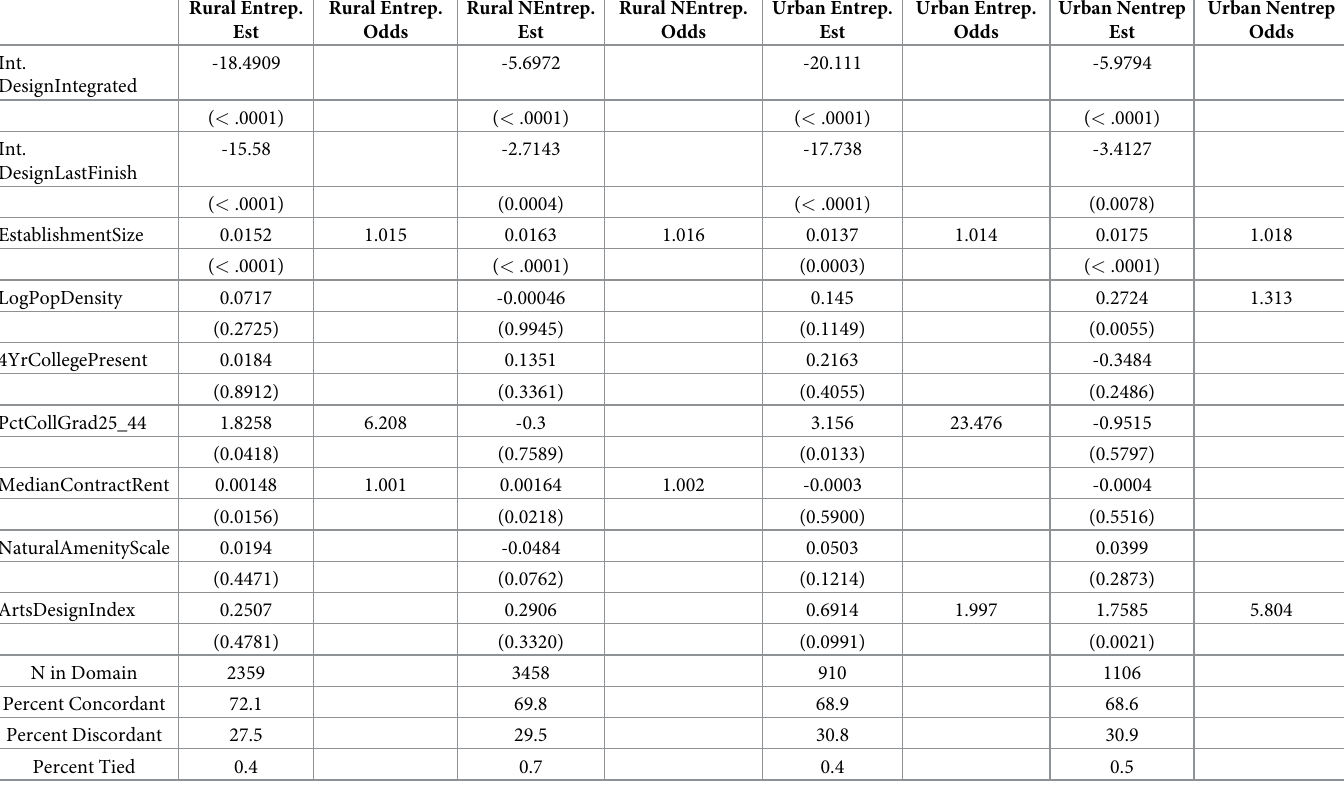
Table 3. Ordered logistic regression of design orientation for domains defined by entrepreneurial/non-entrepreneurial and rural/urban status. Rural Entrep. Rural Entrep. Est